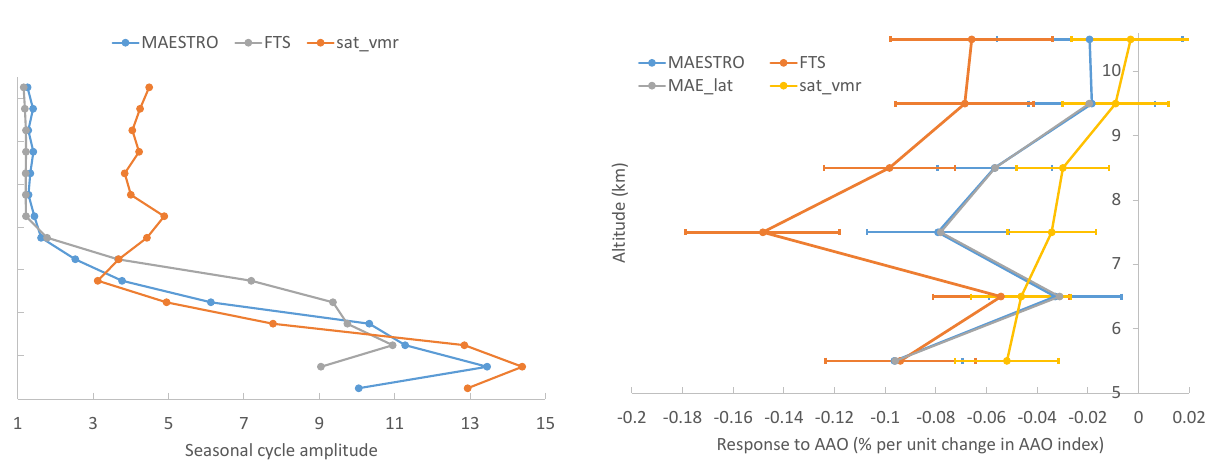
Figure 6. Analogous to Fig. 5 but for northern high latitudes. Pro- files are presented at their respective native vertical resolutions.